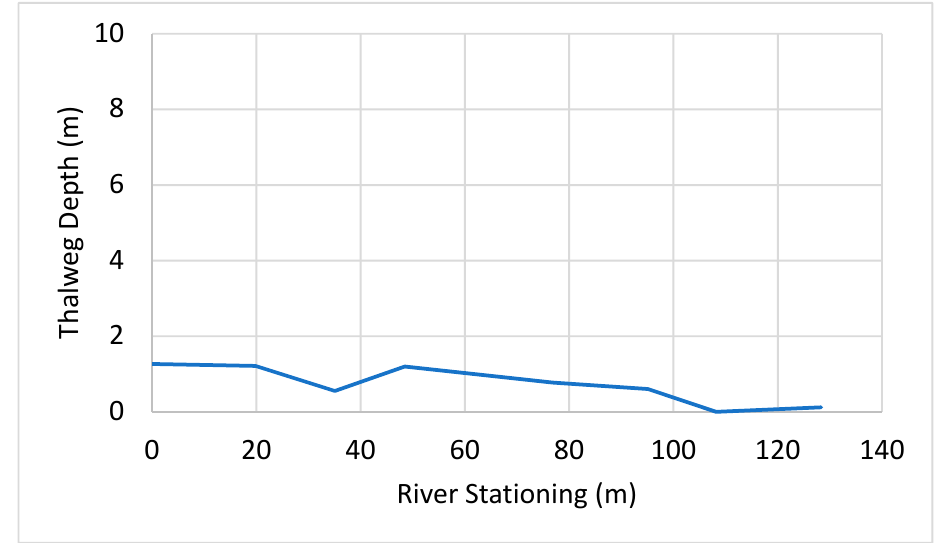
Figure A1. Del Cerro longitudinal slope.